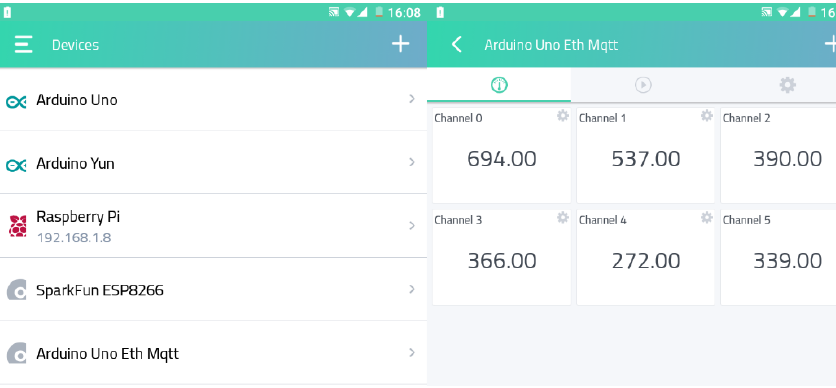
Fig. 2. Cayenne mobile app with installed devices and Arduino Uno analog channels